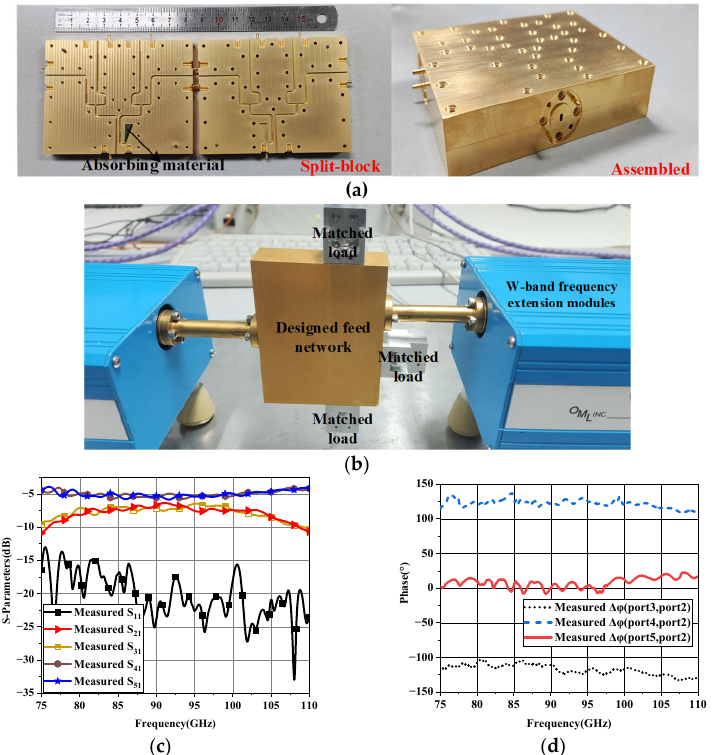
Figure 7. The results of the proposed feed network, ( a ) the photograph of feed network fabricated by E ‐ plane split block CNC ‐ machining; ( b ) the measured environment of proposed feed network; ( c ) the s ‐ parameters results of proposed feed network; ( d ) the phase performance of proposed feed network.